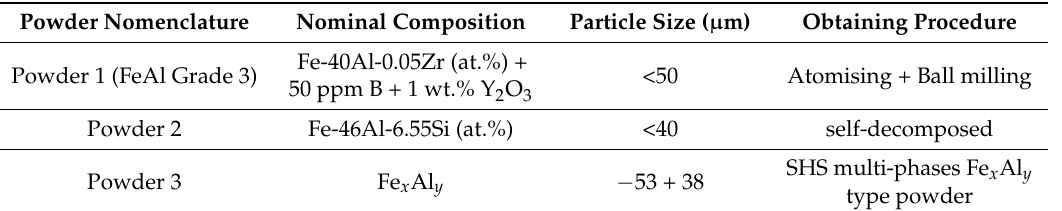
Table 1. Iron aluminide feedstock